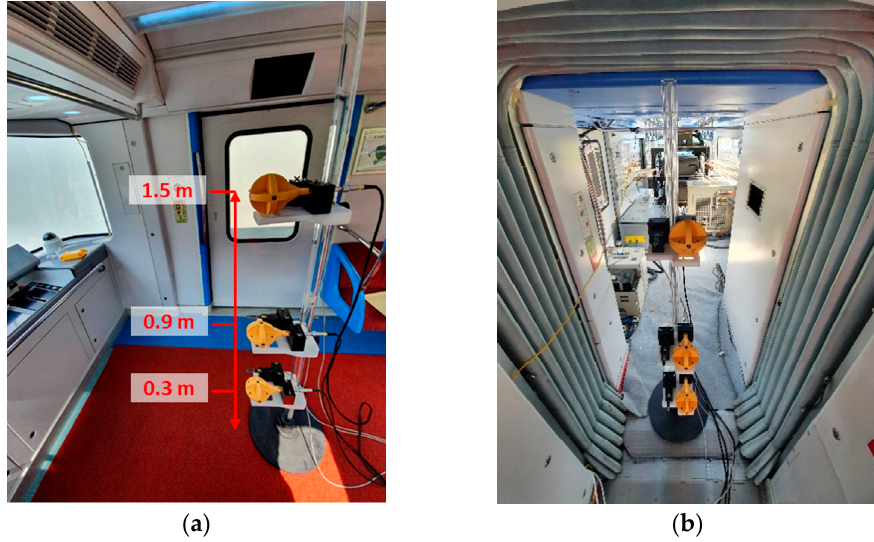
Figure 8. EMF measurement points inside the rolling stock.